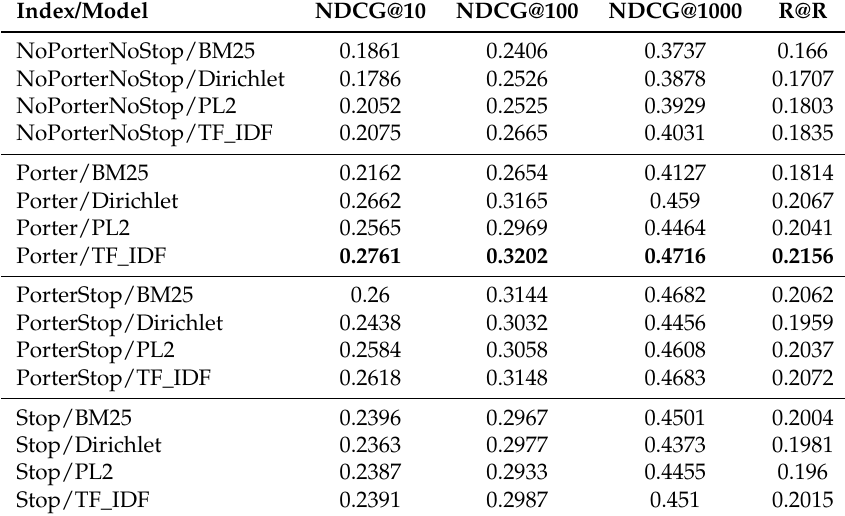
Table 4. NDCG at various cut offs and Recall@R for the different models for T2. The highest values are in